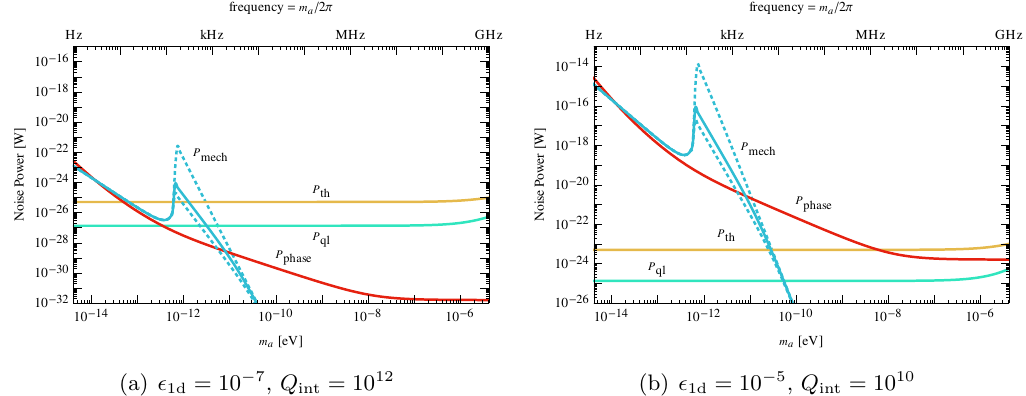
(b) (cid:15) 1d = 10 (cid:0) 5 , Q int = 10 10